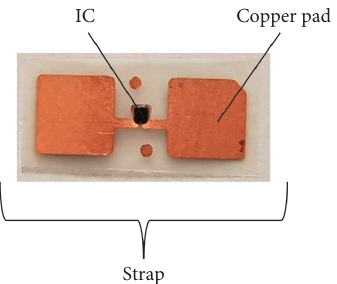
Figure 2: RFID IC strap used as an input